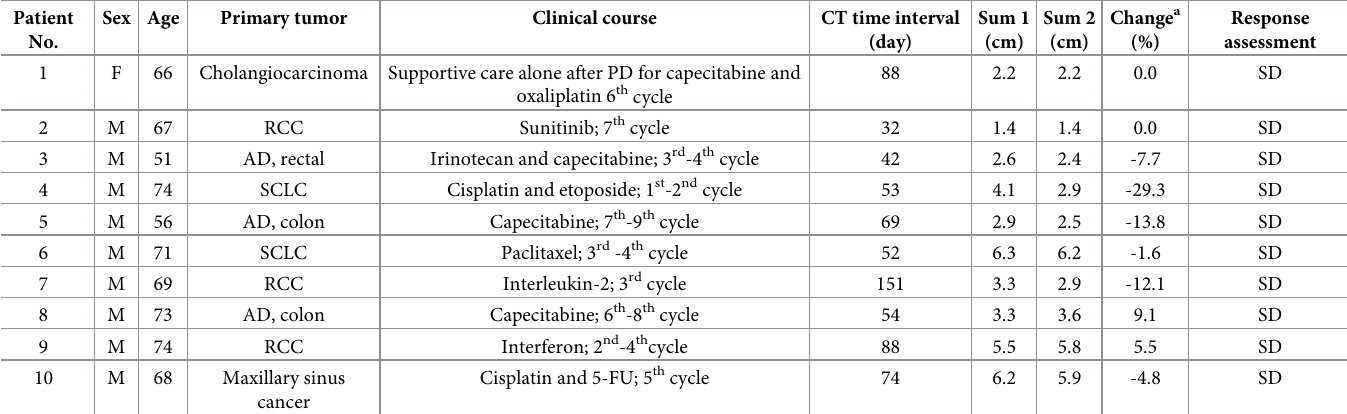
Table 1. The clinical features and tumor response assessment by manual CT measurement in 10 patients with multiple pulmonary metastases. Patient